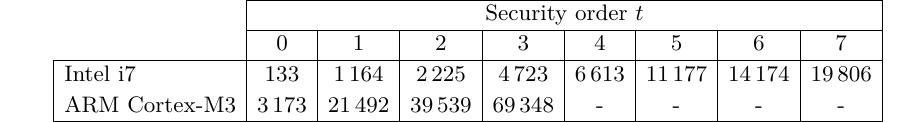
Table 11: Kyber.Decaps cycles counts on Intel(R) Core(TM) i7-1065G7 and ARM Cortex- M3, in thousands of